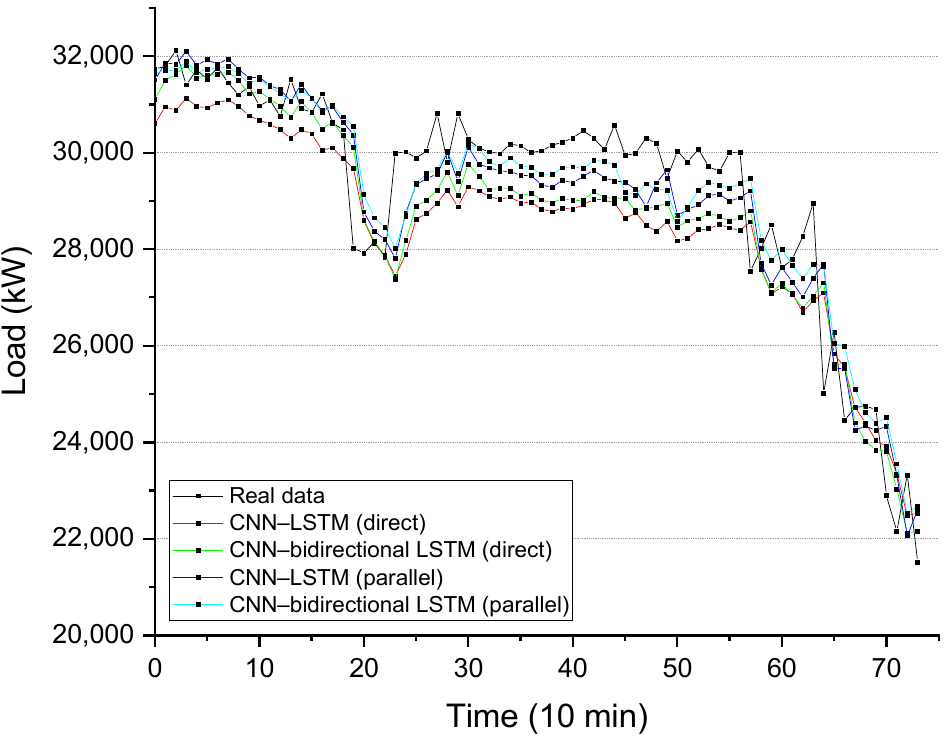
Figure 9. Result of forecast by each model in detail.